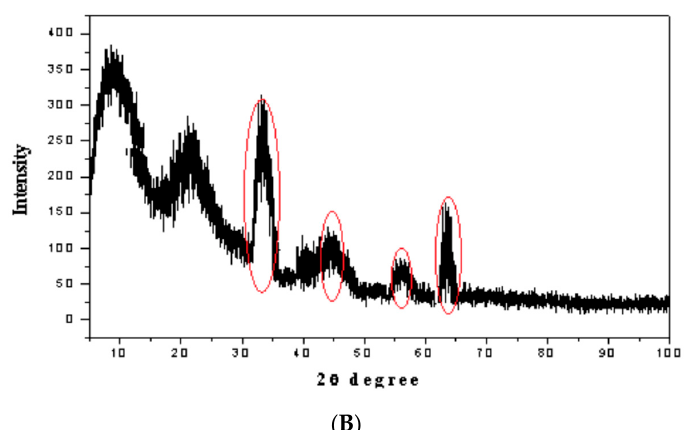
Figure 4. XRD spectrums of ( A ) amine-functionalized silica gel (ANSG) and ( B ) magnetic amine-functionalized silica gel (MANSG).